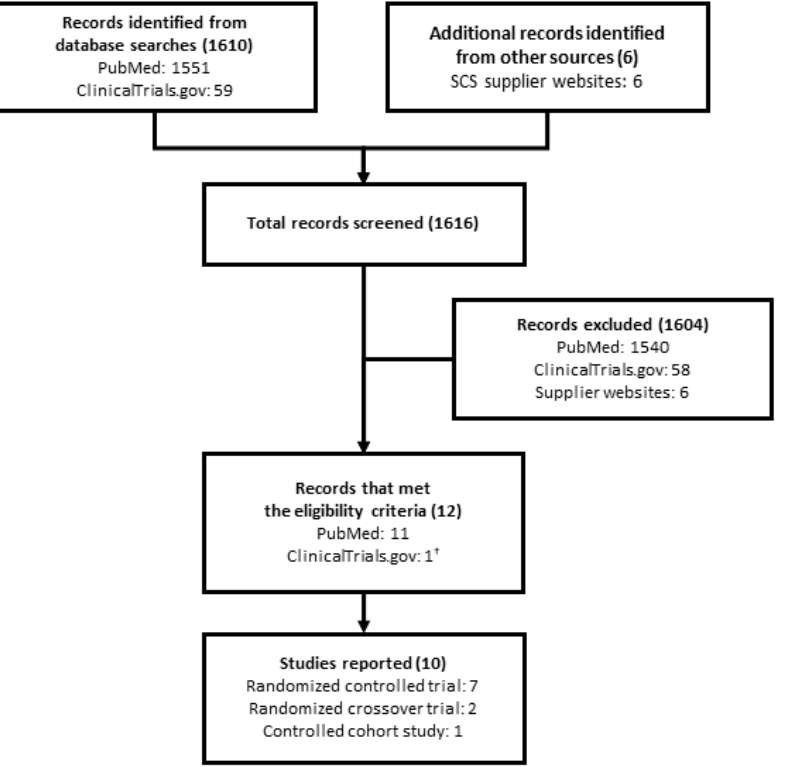
Figure 1. Literature search flow chart.